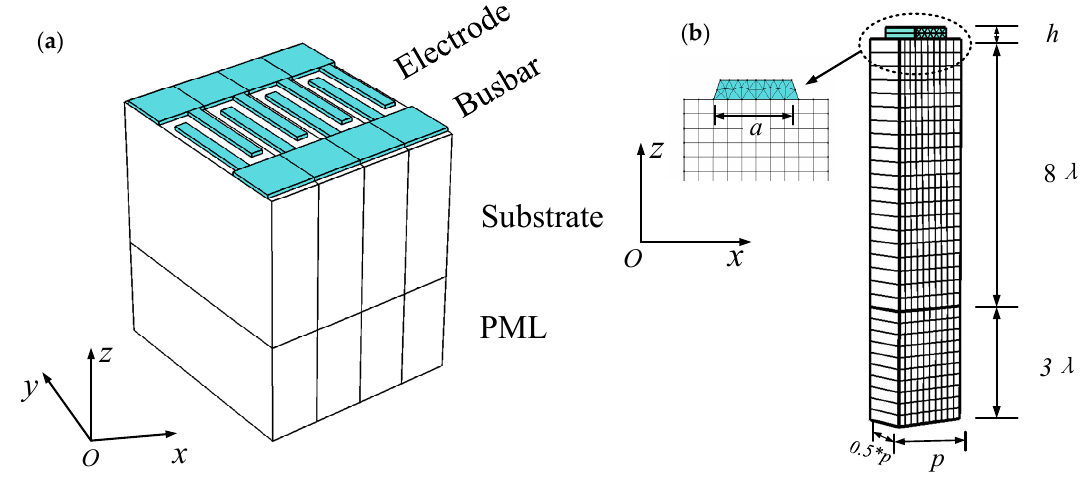
Figure 1. Schematic diagram of the three-dimensional model. ( a ) The geometrical structure of SAW devices; ( b ) quasi-3D FEM mesh model of SAW